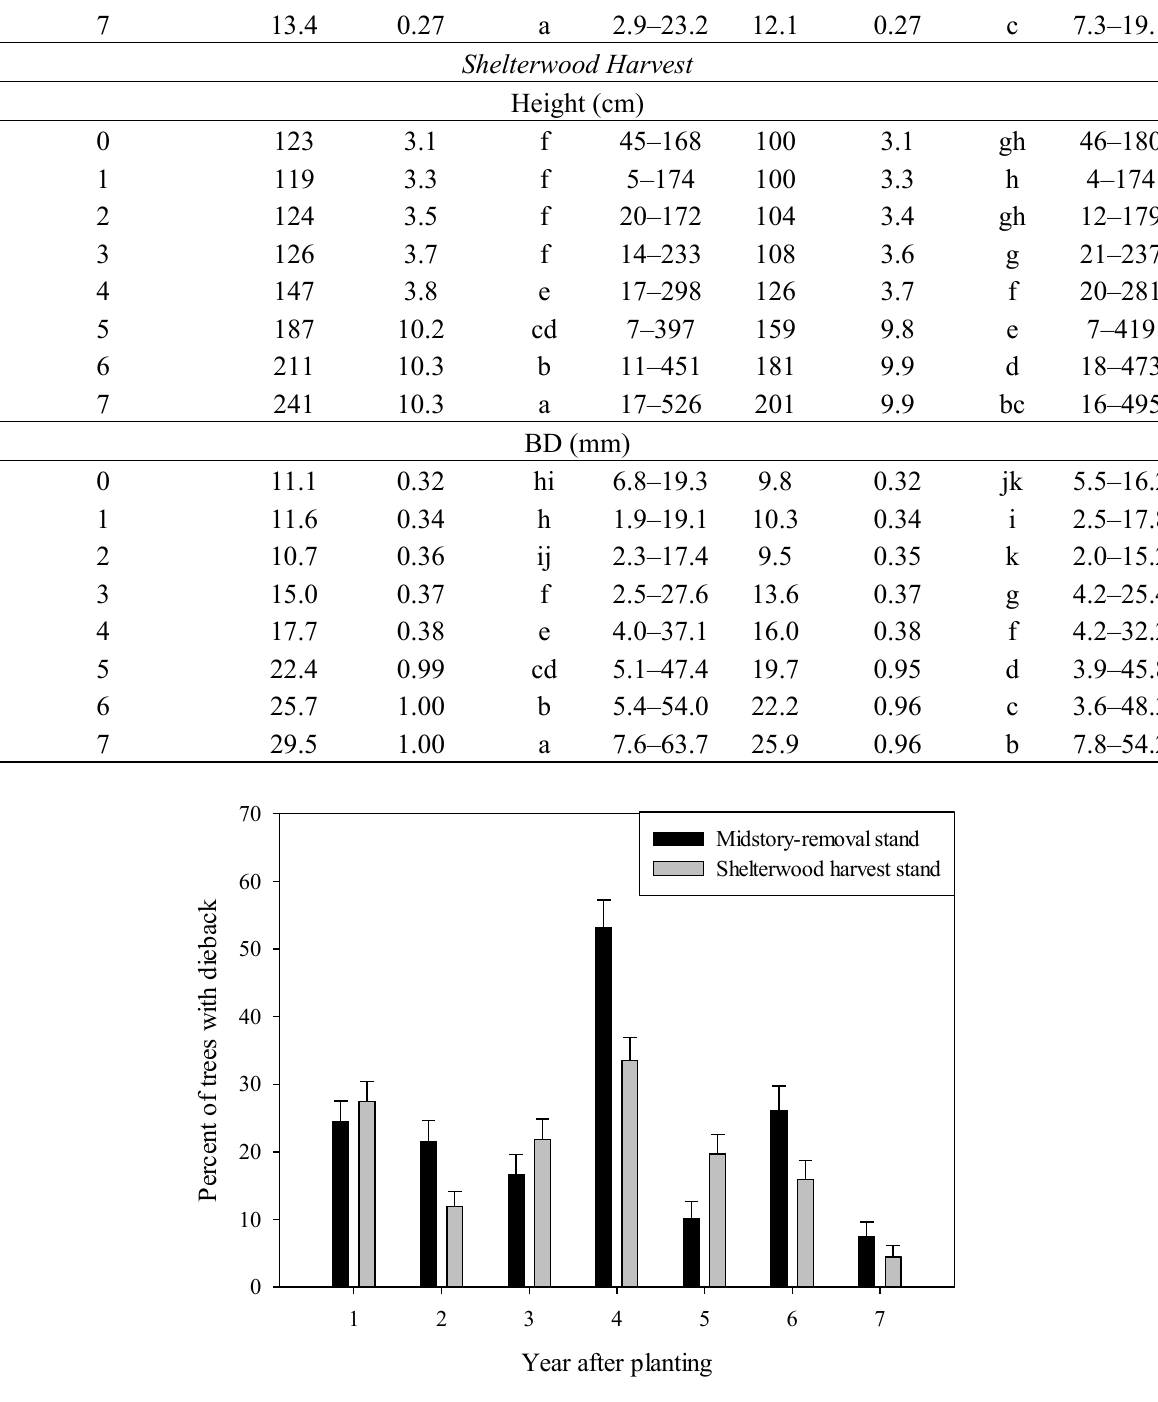
Figure 2. Least-squares means and associated standard errors for percent of trees with stem dieback of northern red oak seedlings planted in a midstory-removal and a shelterwood harvest